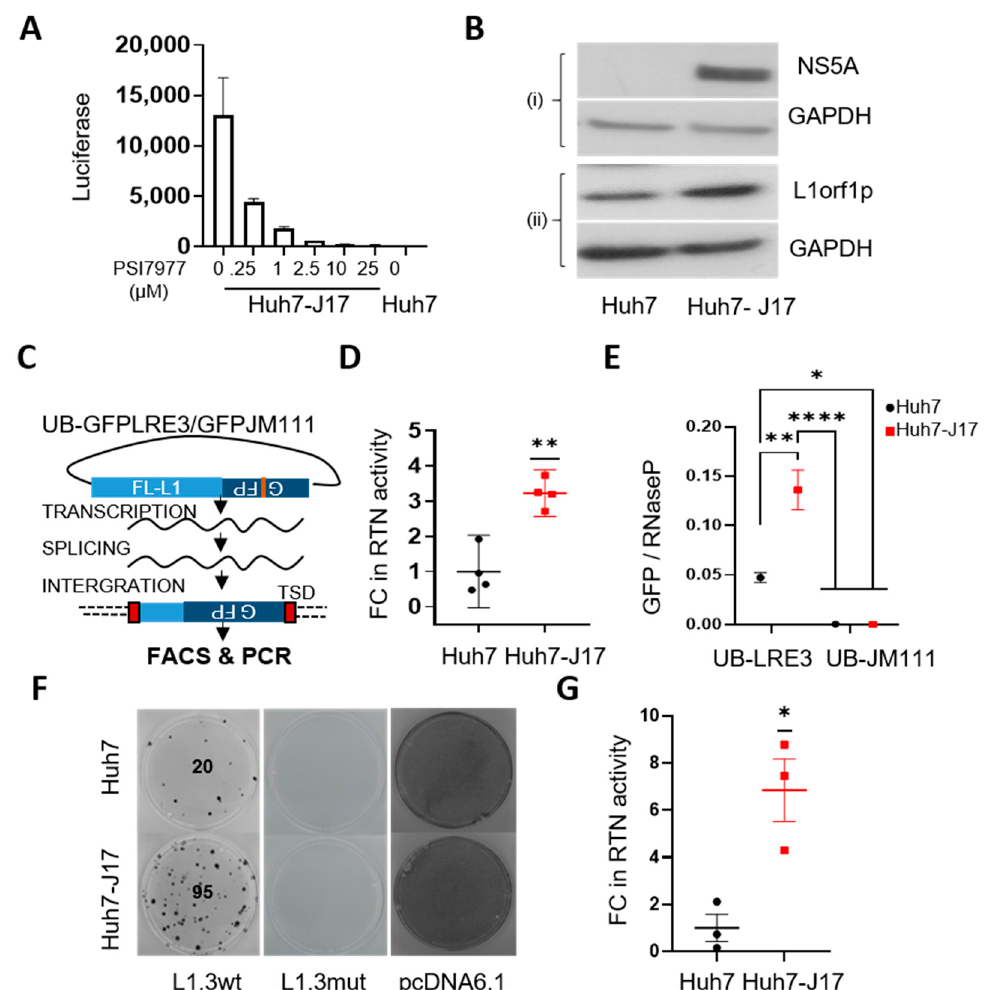
Figure 2. HCV activates L1s. Luciferase expression levels (indicator of HCV replicon level) in Huh7-J17 cells upon treatment with indicated doses of PSI7977 (sofosbuvir) for 48 h. Parental Huh7 lysate was used as a negative control. Bars represent the mean ± SE of 2 technical repeats ( A ). Western blot images of whole-cell lysates of Huh7 and Huh7-J17 cells probed with the indicated antibodies. GAPDH was used as a loading control ( B ). Schematic representation of the retrotransposition assay with EGFP indicator cassette. UB denotes the presence of the UB promoter before the L1-retortransposition cassette. The JM111 plasmid contains a mutation in L1ORF1 (RR260-261AA) of the LRE3 sequence, rendering it retrotransposition-incompetent and it is thus used as a negative control ( C ). The results of the retrotransposition assay in Huh7 cells in the presence and absence of HCV: graph representing fold change (FC) in the number of retrotransposition (RTN)-positive cells observed via FACS analysis 5 days after transfection with UB-GFPLRE3 plasmid, where the negative gate was set using cells transfected with UB-GFPJM111 plasmid, n = 4 independent repeats ( D ), quantification of GFP insertions in the genome using RNaseP as a control, n = 3 technical replicates of one representative Taqman qPCR assay ( E ) and blasticidin-resistant colonies representative of active retrotransposition events, visualised via crystal violet staining 3 weeks after selecting cells with blasticidin. Blasticidin selection was started 5 days after transfection with a retrotransposition plasmid-containing blasiticidin indicator cassette (L1.3wt or negative control plasmid L1.3mut, which contains a missense mutation (D702Y) in the reverse transcriptase domain of L1ORF2-protein, rendering it retrotransposition incompetent, and pcDNA6.1, constitutively expressing a blasticidin resistance cassette as a positive control for transfection efficiency and blasticidin resistance). The image is representative of 3 independent repeats done in duplicates. Numbers represent the number of colonies in the plate ( F ) and the graph represents the fold change in number of colonies representing active retrotransposition taking Huh7 cells as control ( G ). * p < 0.05, ** p < 0.01, **** p < 0.0001, one-sample t -test ( D,G ) and one-way ANOVA with Tukey’s multiple testing correction ( E ). Detailed information about the Western blotting can be found in Figure S2. Key: GFP = Green Fluorescent Protein; RTN = Retrotransposition; FC = Fold Change; TSD = Target Site Duplication; FACS = Fluorescence Activated Cell Sorting; FL-L1 = Full Length L1 element; NS5A = nonstructural protein 5A; L1orf1p = L1 open reading frame encoded protein; GAPDH = Glyceraldehyde 3-phosphate dehydrogenase; UB = Ubiquitin; HCV = Hepatitis C Virus; SE = Standard Error.